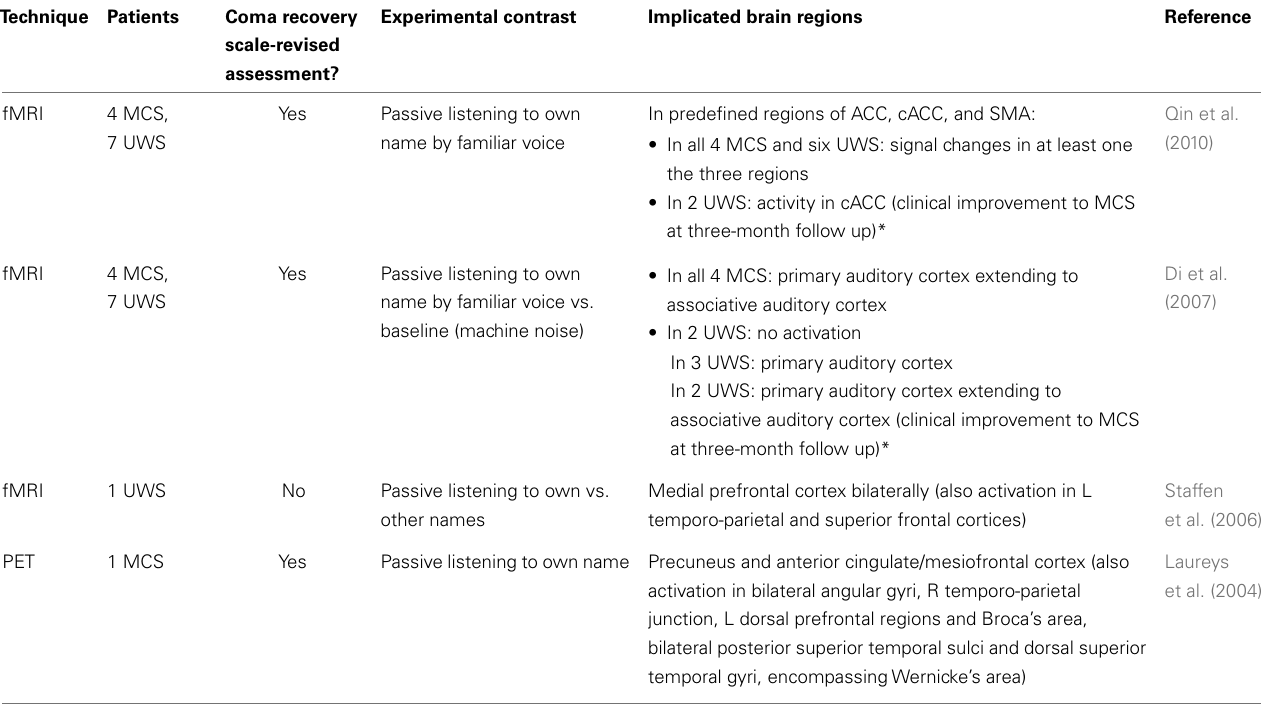
Table 1 | Studies showing brain responses to the presentation of self-referential stimuli in patients in vegetative state/unresponsive wakefulness syndrome (UWS) and minimally conscious state (MCS) by means of positron emission tomography (PET) and functional magnetic resonance imaging (fMRI) techniques (*indicates prognostic value).